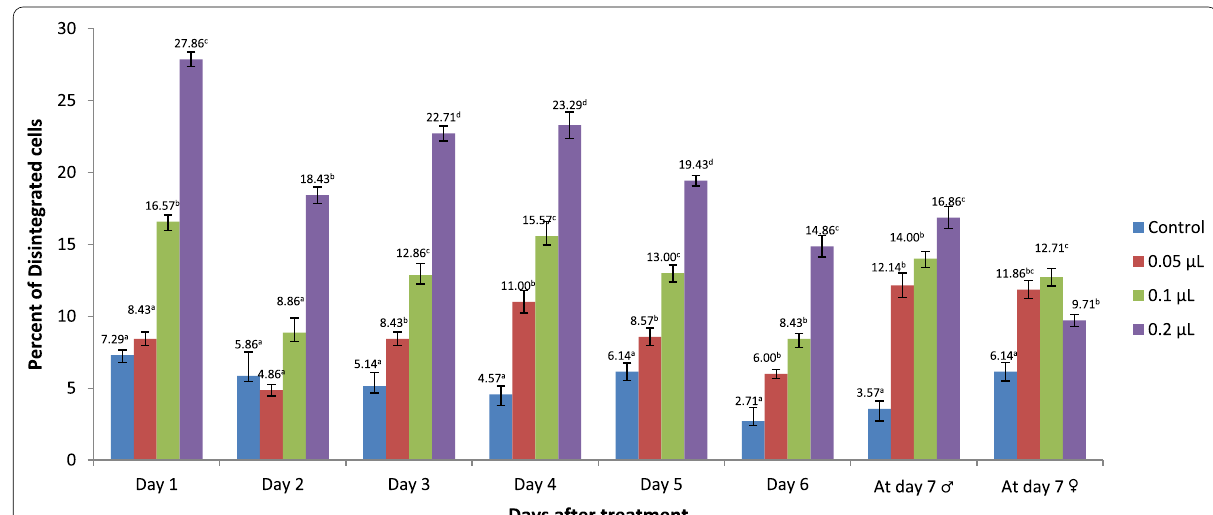
Fig. 7 Effect of Farnesol on Disintegrated cells of fifth instar nymphs of Dysdercus koenigii. Each bar represents Mean taken for calculation of mean Bars on a specific day after treatment with different letter are significantly different ( p < 0.05), computed by one-way ANOVA followed by Tukey’s all pairwise multiple comparison